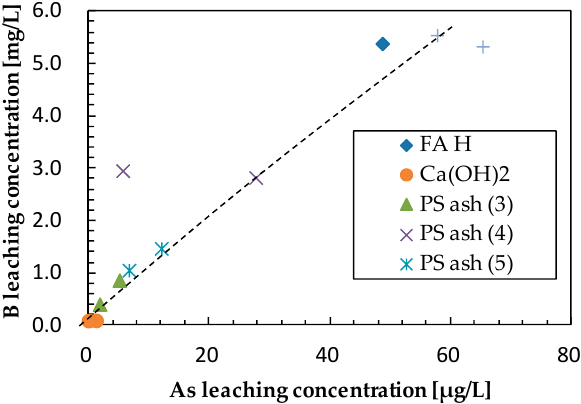
Figure 9. Relationship between the arsenic leaching concentration and the boron leaching concentration.